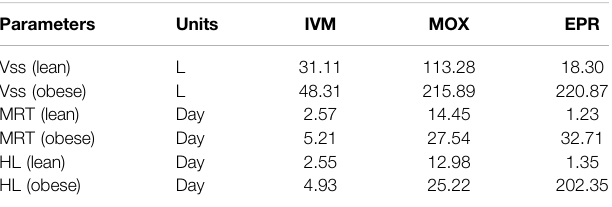
TABLE 3 | Population secondary parameters obtained with a 3-compartments model with covariate (COV) (lean vs. obese); estimates were obtained from typical values of primary parameters of Table 2 .